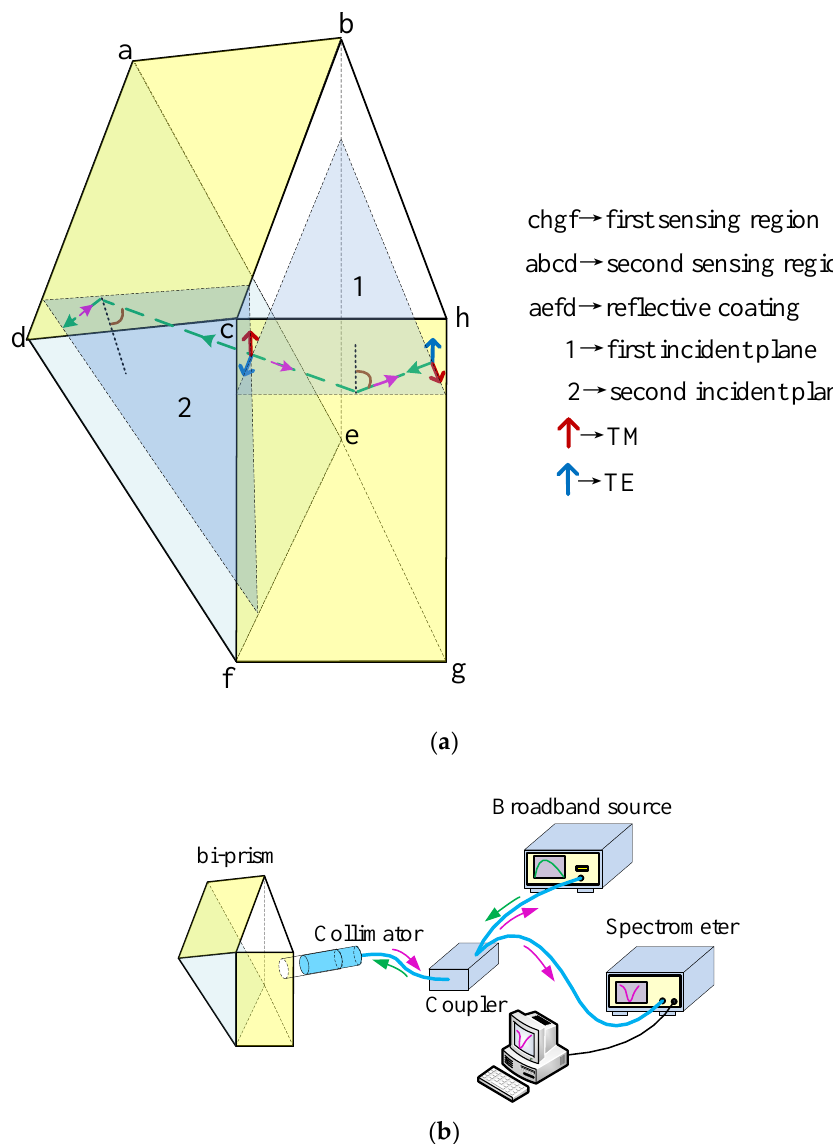
Figure 1. ( a ) Proposed sensor based on bi-prism. The bi-prism reverses the polarization state of light reflected by first sensing region. The reflected light strikes the second sensing region, then be reflected by the reflective coating normally; and ( b ) Schematic diagram of sensing system.